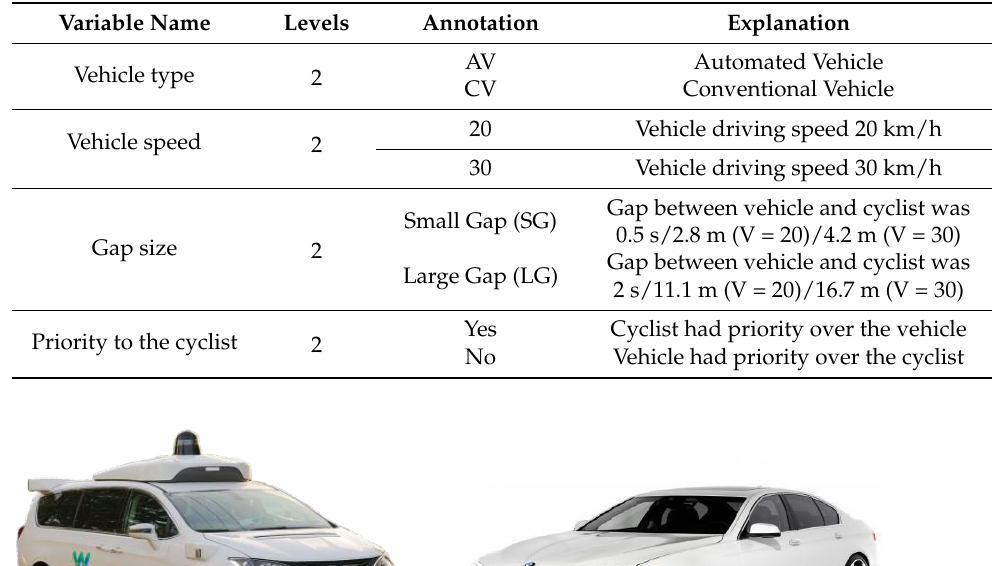
Table 1. Variables included in the VR experiment.